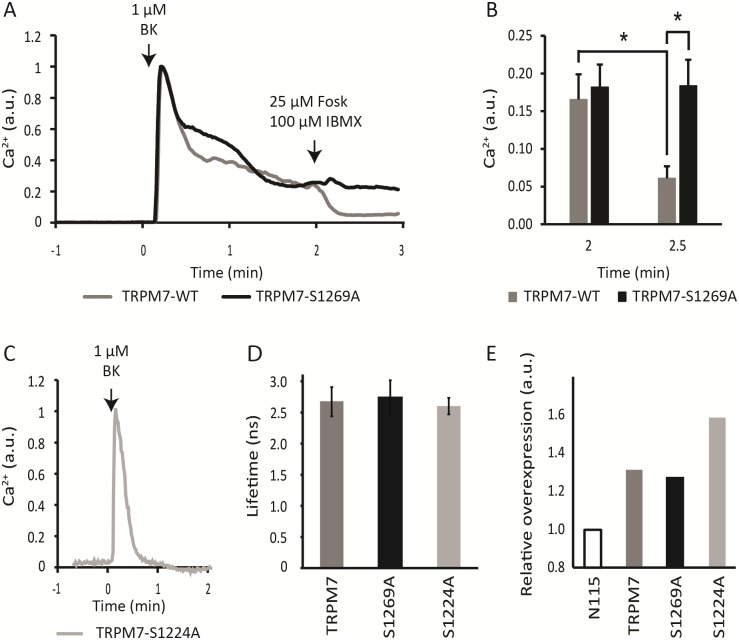
The S1269A phosphorylation-dead mutant is insensitive to cAMP-mediated termination of Ca2+ influx.(A) Representative traces of Ca2+ responses in TRPM7-S1269A mutant (black) and TRPM7-WT (grey) expressing cells. Note that in the S1269A mutant sustained influx fails to terminate after being challenged with IBMX/forskolin (arrow). (B) Quantification of Ca2+ levels before (left bars, taken 2 min after addition of BK) and 30 s after (right bars) addition of IBMX/forskolin and expressed as average + SD of N = 7 TRPM7-WT (gray) and N = 10 TRPM7-S1269A (black) cells. IBMX/forskolin were added at 2 minutes post BK addition. In TRPM7-WT expressing cells but not in S1269A mutant expressing cells cAMP caused a significant drop in calcium levels (P = 0.016). The difference between TRPM7-WT and TRPM7-S1269A expressing cells following addition of IBMX/forskolin is also significant (P = 0.013). (C) Ca2+ response following stimulation with BK in cells transfected with TRPM7-S1224A shows absence of sustained influx. Similar results were obtained in 3 experiments of 3–4 cells each. (D) Fluorescence Lifetimes of Epac-SH189 in N1E-115 cells expressing wtTRPM7, S1269A and S1224A demonstrate that basal cAMP levels do not differ among these cell lines. (E) Transduction was checked by qPCR. A moderate 1.3x overexpression of S1269A was seen, as is common for N1E-115-TRPM7 cells. S1224 had a 1.6x overexpression. Note that although moderate, the overexpression levels observed are in line with literature reports [14, 40].